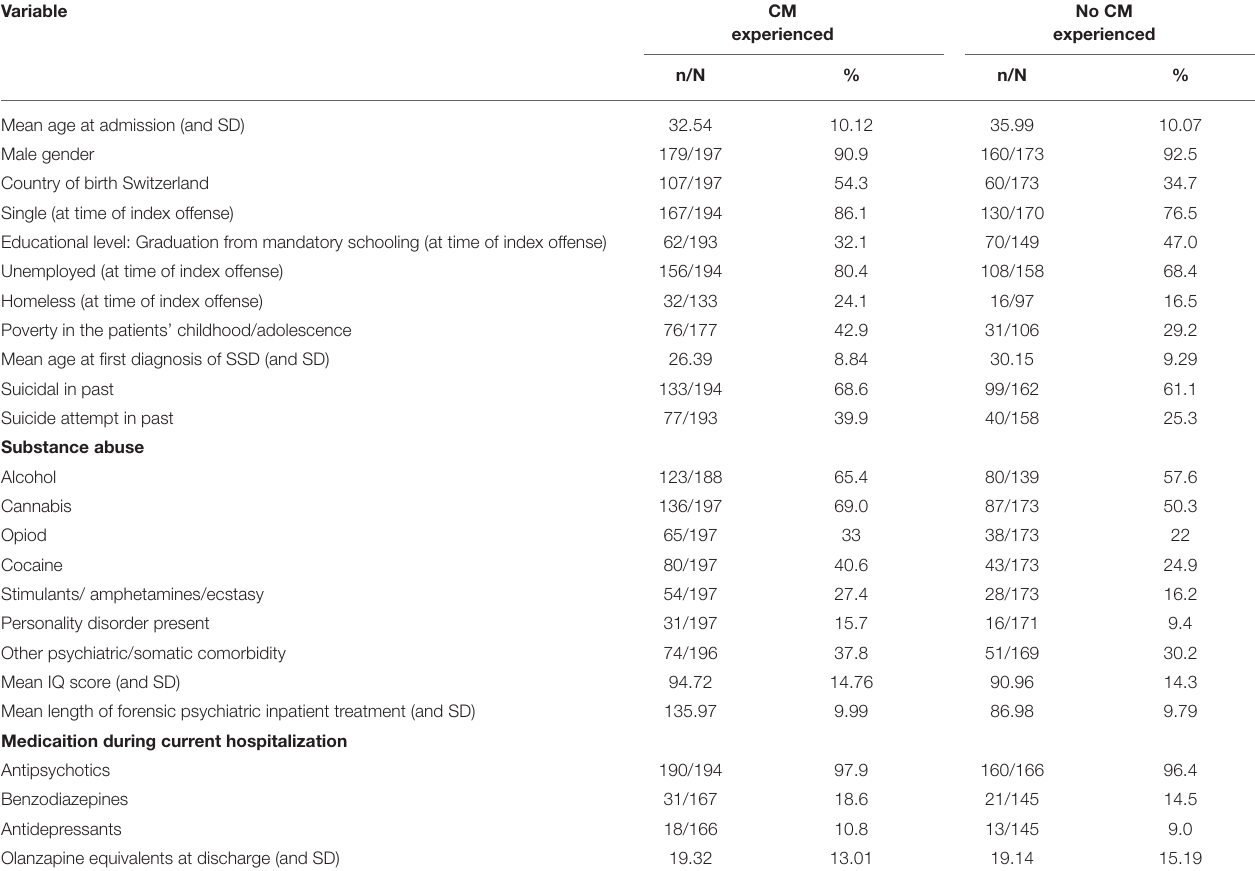
TABLE 1 | Descriptive statistics on offender patients with SSD and CM vs. with SSD without CM. Variable